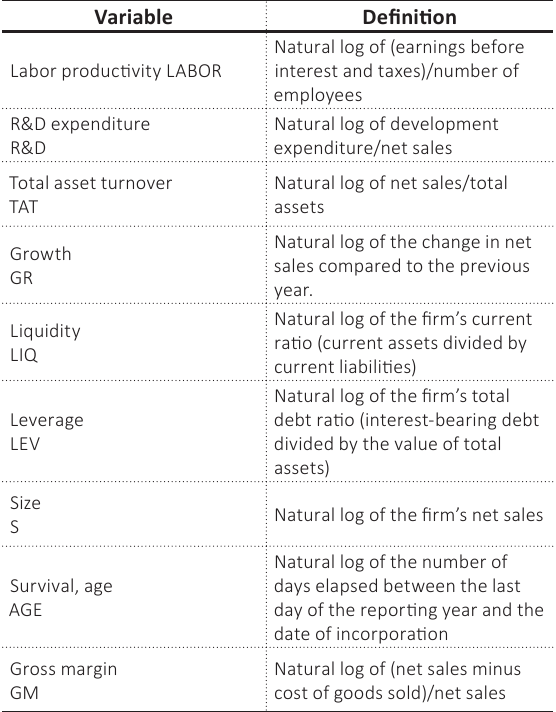
Table 2. Variable definitions and calculation